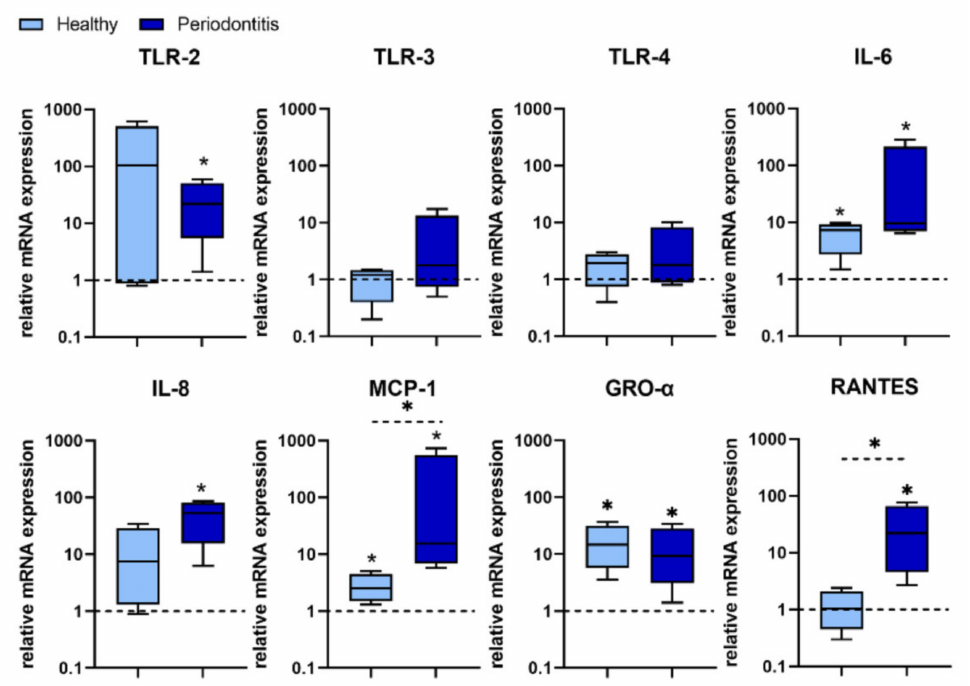
Figure 5. Expression of genes associated with inflammation in GMSCs treated with P. gingivalis . The basic level of each mRNA expression is counted as 1 (non-treated GMSCs) and is marked with a dotted line. The asterix above the boxes indicates the significant difference between non-treated and P. gingivalis treated H- or P-GMSC lines (* p < 0.05). The asterix above the line indicates the significant difference between H- and P-GMSCs treated with P. gingivalis (* p < 0.05); n = 4 in each group.